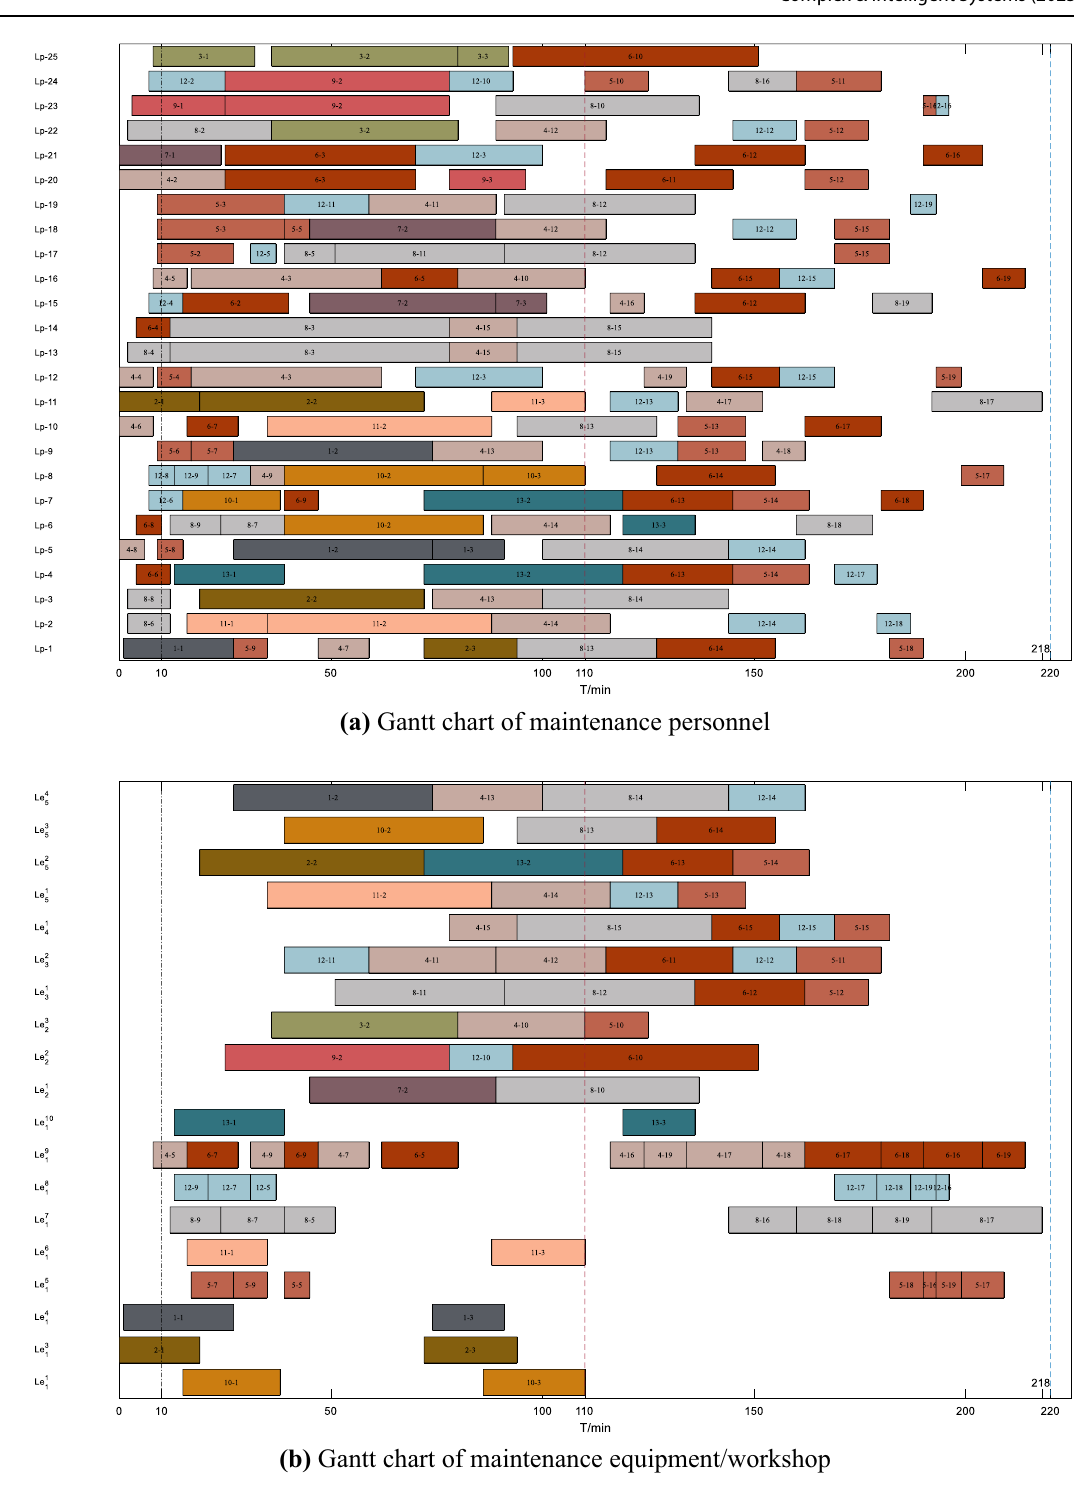
Fig. 12 Baseline schedule for 13 carrier-based aircraft